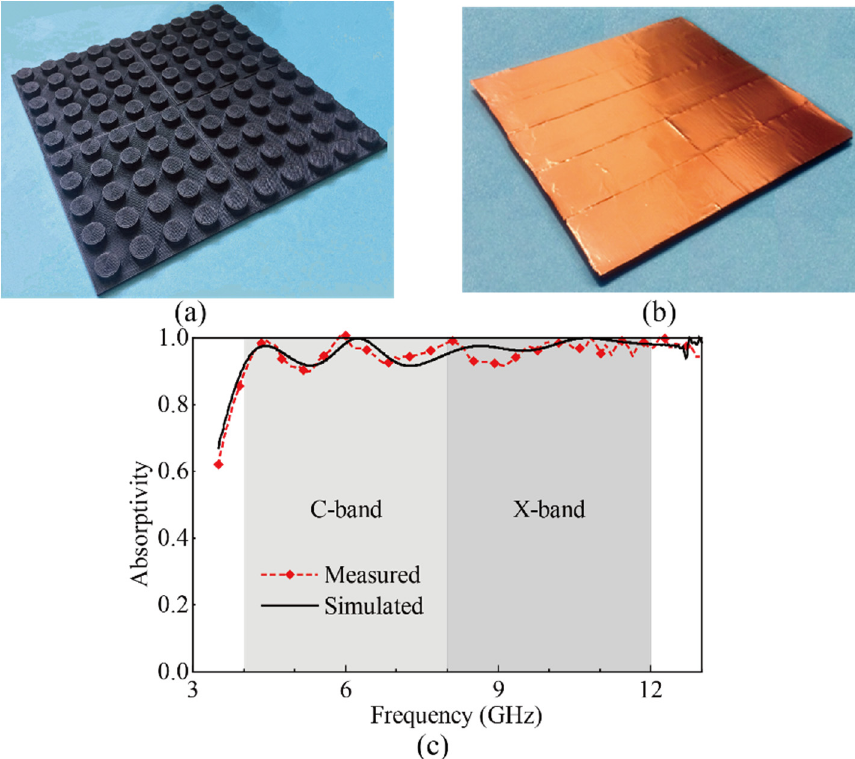
Figure 5. Photo of prototype of the designed absorber. ( a ) Top side; ( b ) Bottom side; ( c ) Simulated and measured absorption spectra of the proposed absorber.